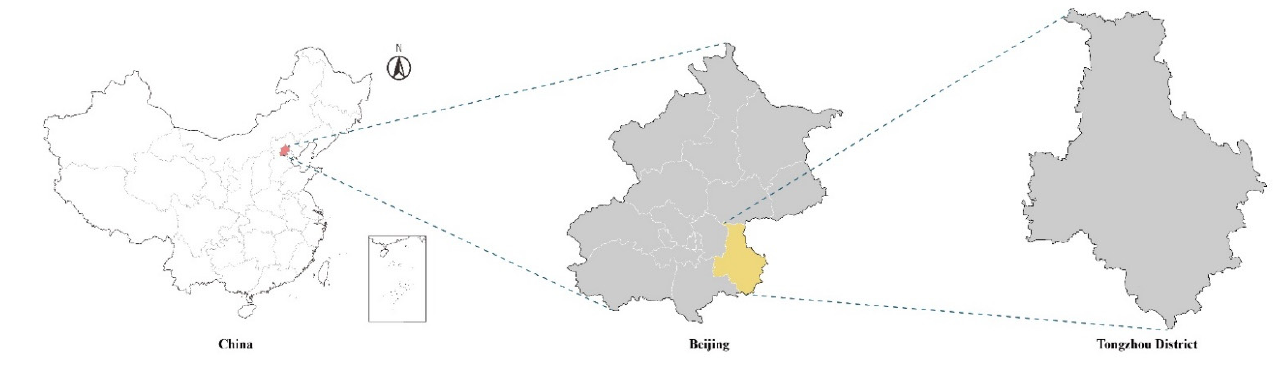
Figure 1. Location map of Tongzhou District.